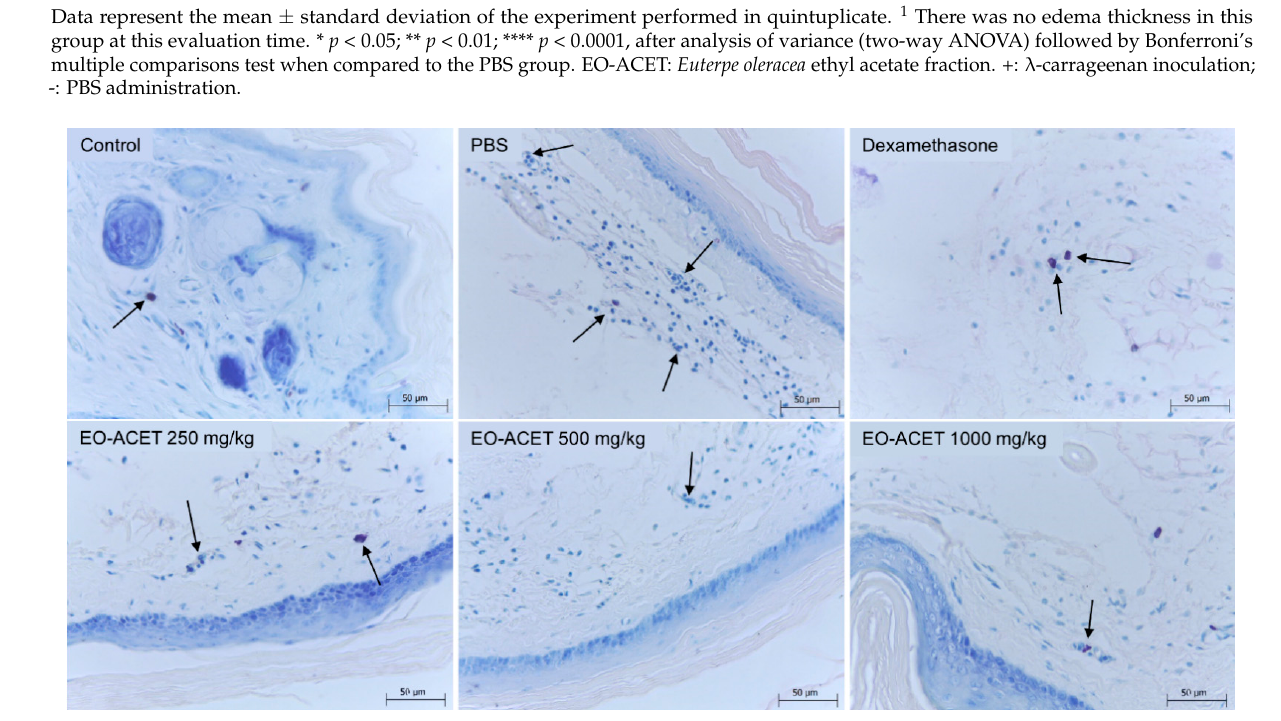
Figure 5. Paw edema of BALB/c mice inoculated with of λ -carrageenan and treated with Euterpe oleraceae ethyl acetate fraction (EO-ACET). Macroscopy ( A ) and kinetic of edema thickness ( B ) of animals inoculated with 25 µL of λ -carrageenan 1% and treated with 100 µL EO-ACET (purple lines) at 250, 500 or 1000 mg/kg by gavage or with dexamethasone (blue